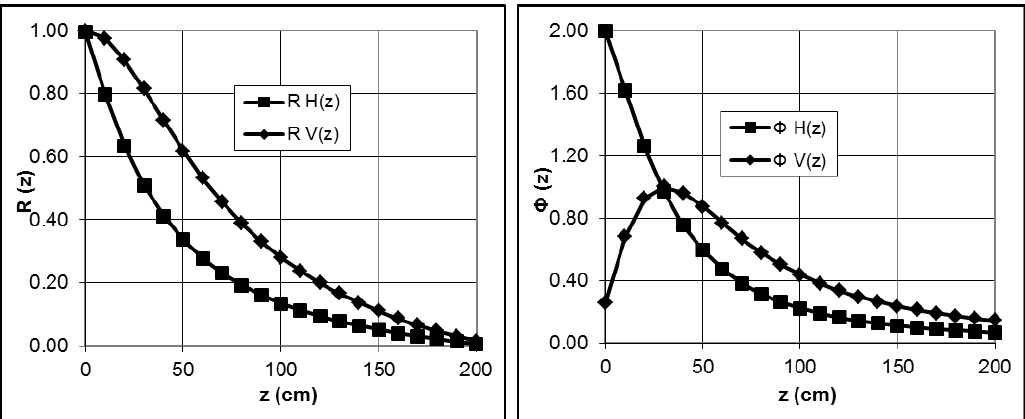
Figure 1. ( Left ) Relative cumulative contribution vs depth for vertically (RV( z )) and horizontally (RH( z )) orientated dipoles; ( Right ) Comparison of the relative responses for vertically (FV( z )) and horizontally (FH( z )) oriented dipoles.